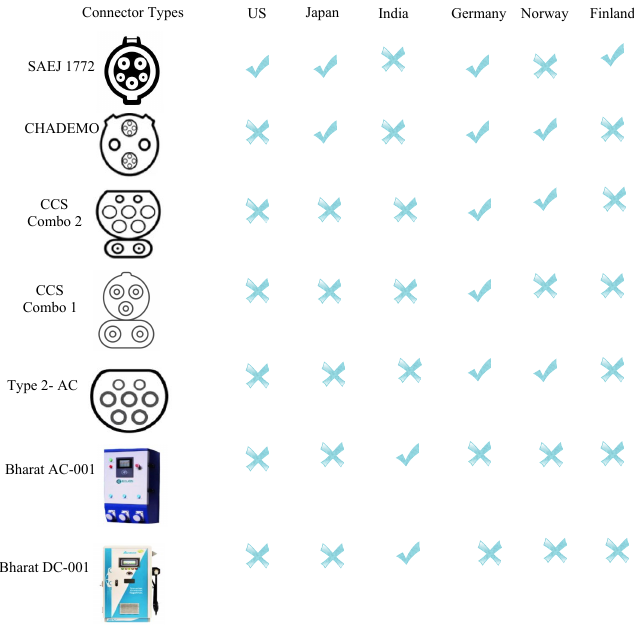
Figure 4. Taxonomy of charging standards based on the